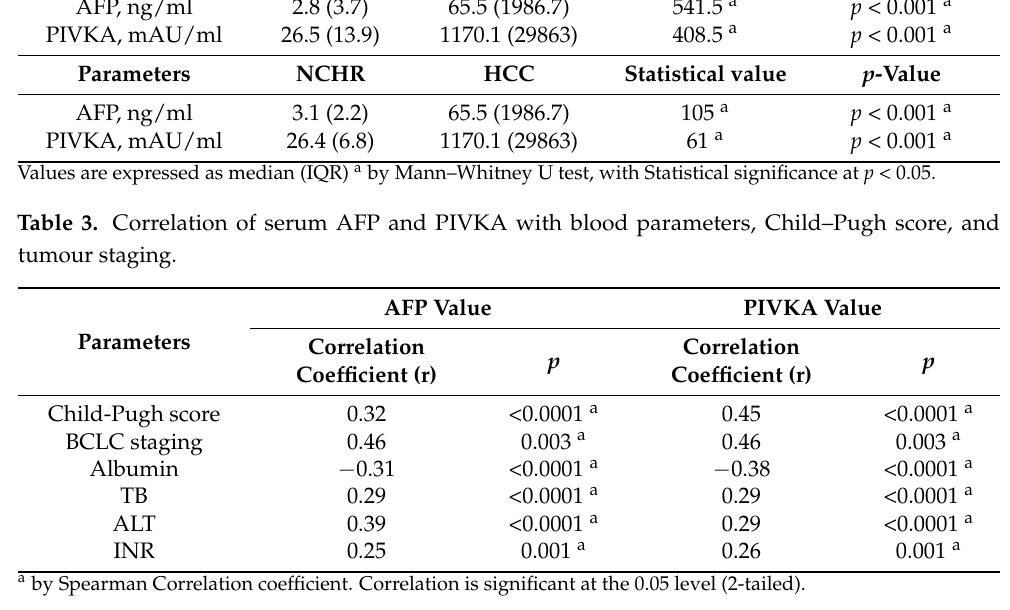
Table 2. Values of AFP and PIVKA in HCC, LC, and non-cirrhotic high-risk (NCHR) groups. Parameters